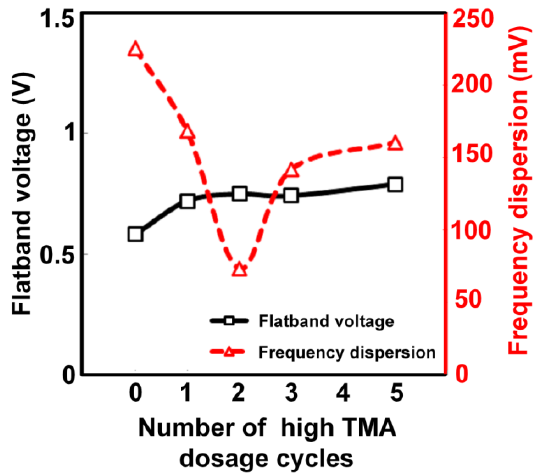
Figure 5. The flatband voltage V high-dosage